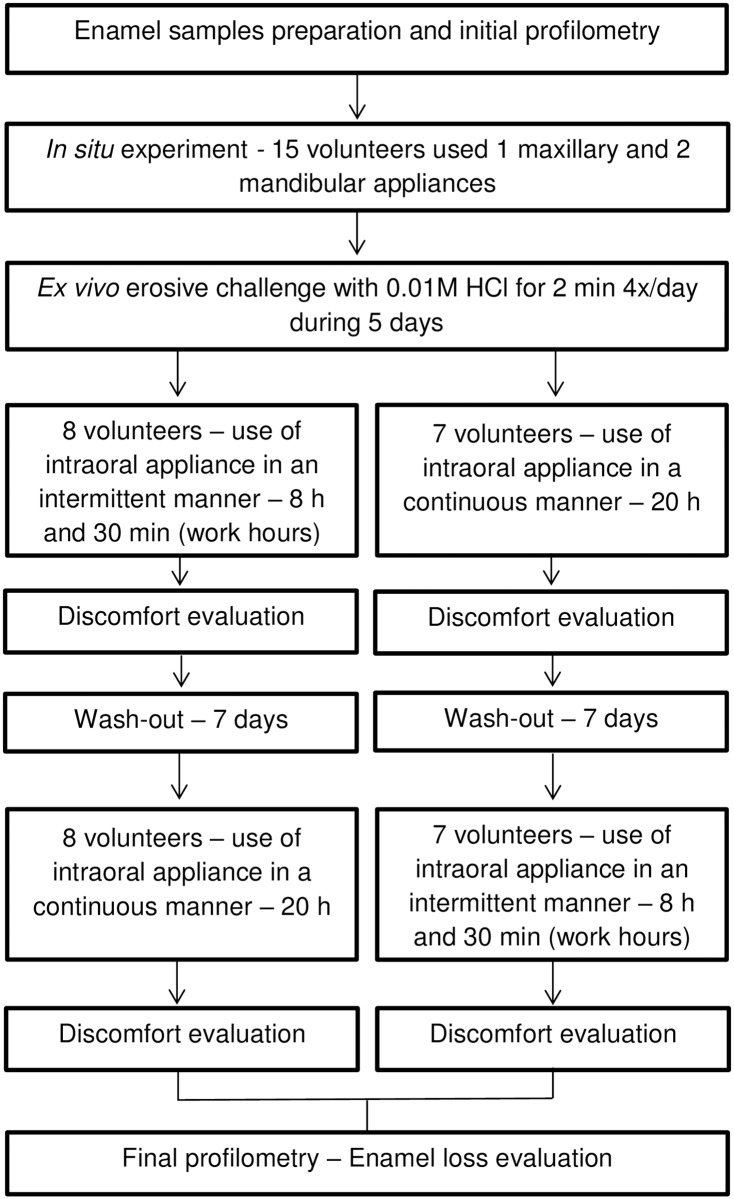
Flowchart of the study.